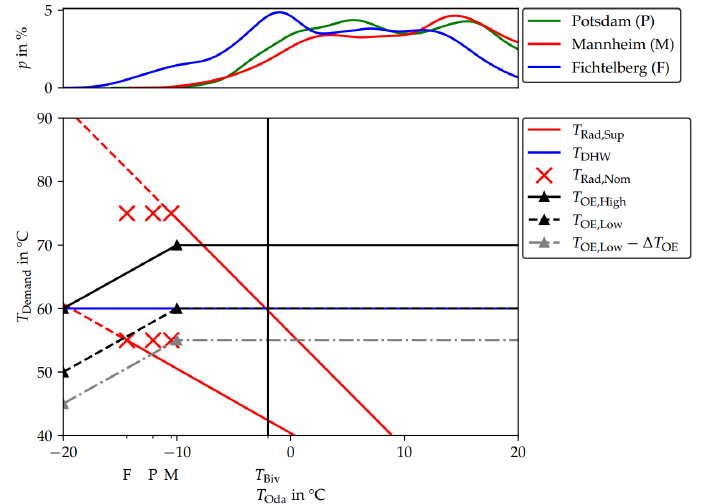
Figure 3. The temperature demands of all case studies are depicted in the lower part. The histogram curves of the outdoor air temperature probabilities p are depicted in the upper part for the three loca- tions: Fichtelberg (F), Potsdam (P), and Mannheim (M). Further, the nominal outdoor air temperature is indicated in the lower